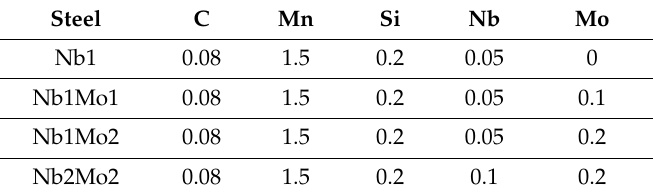
Table 1. Chemical composition (wt.%) of the four investigated